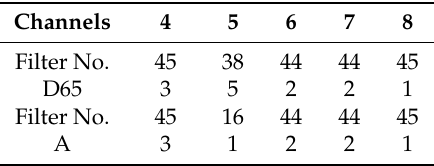
The sequential number in ascending order from the 45 condition numbers for the best-performed filter sets under CIE standard illuminant D65 and CIE standard illuminant A.